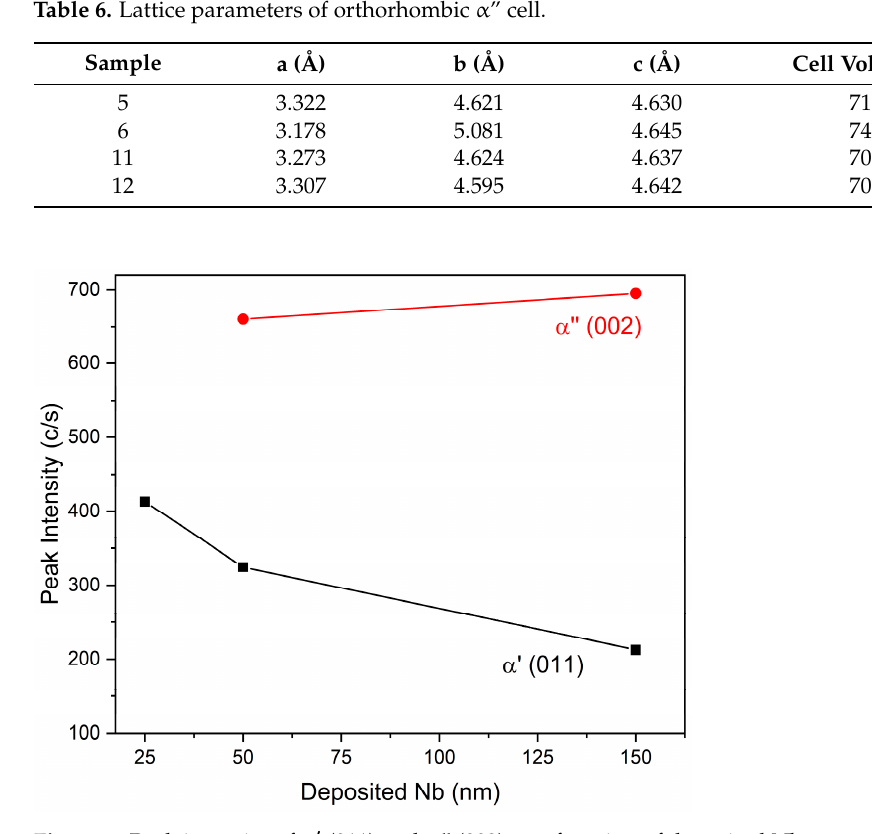
Figure 9. Peak intensity of α′ (011) and α″ (002) as a function of deposited Nb. Different results were obtained with samples of set II. A higher applied voltage and number of pulses promoted the melting and the interdiffusion of Nb and Ti, with the for- mation of an α′ hcp Ti–Nb alloy (Figure 10). Lattice parameters of the α′ hcp and cell vol- ume ( (cid:1848) = (cid:1853) (cid:2870) (cid:1855)(cid:1871)(cid:1857)(cid:1866) 60°) were calculated from the XRD reflections in a Bragg–Brentano con- figuration and are listed in Table 7 for all samples with hcp structure. Figure 10. XRD patterns of samples of set II (grazing incidence angle).